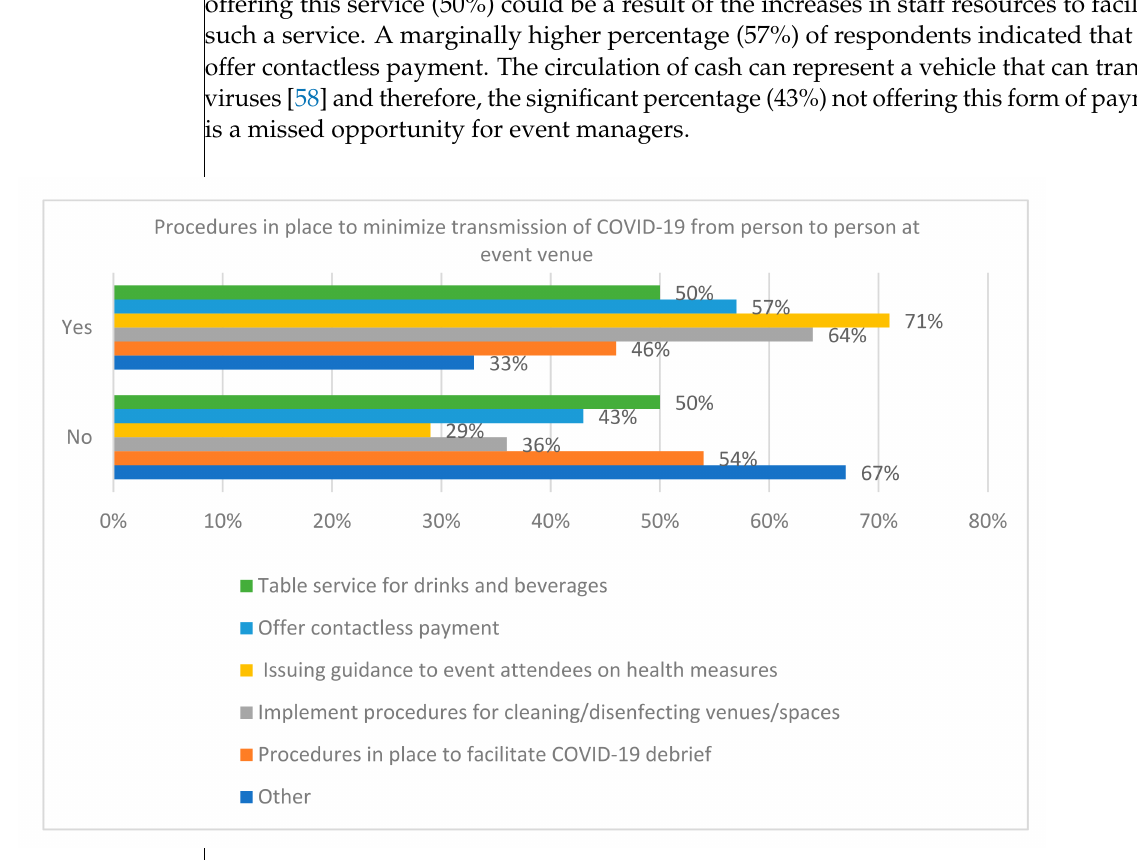
Figure 5. Procedures in place to minimize transmission of COVID-19 from person to person at event venue ( n =